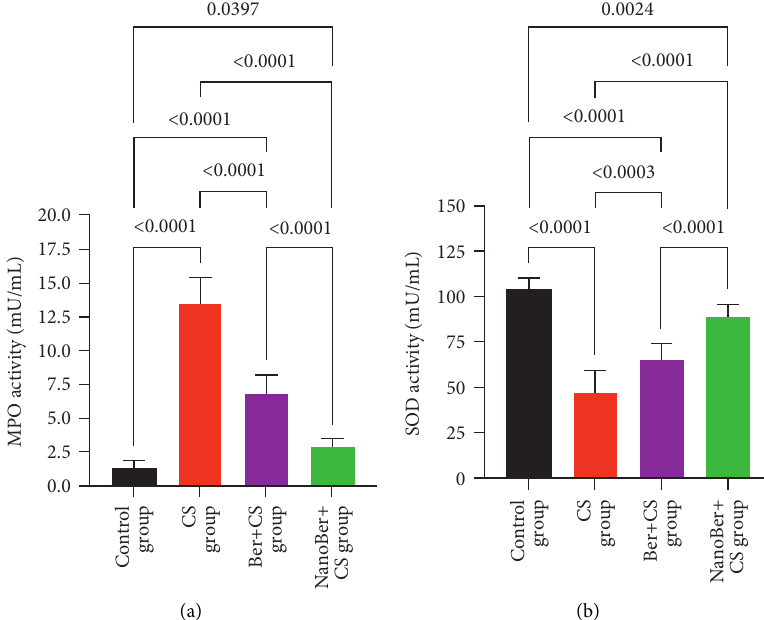
Figure 6: Effect of Ber-loaded SLN-chitosan nanoparticles and the pure suspension of berberine on the activity of MPO and SOD in BALF in CS-induced COPD rats. Data are expressed as mean ± SD ( n � 10). Statistical analysis was carried out by one-way analysis of variance (ANOVA) followed by Tukey’s multiple comparison test. p < 0 . 05 is considered as statistically